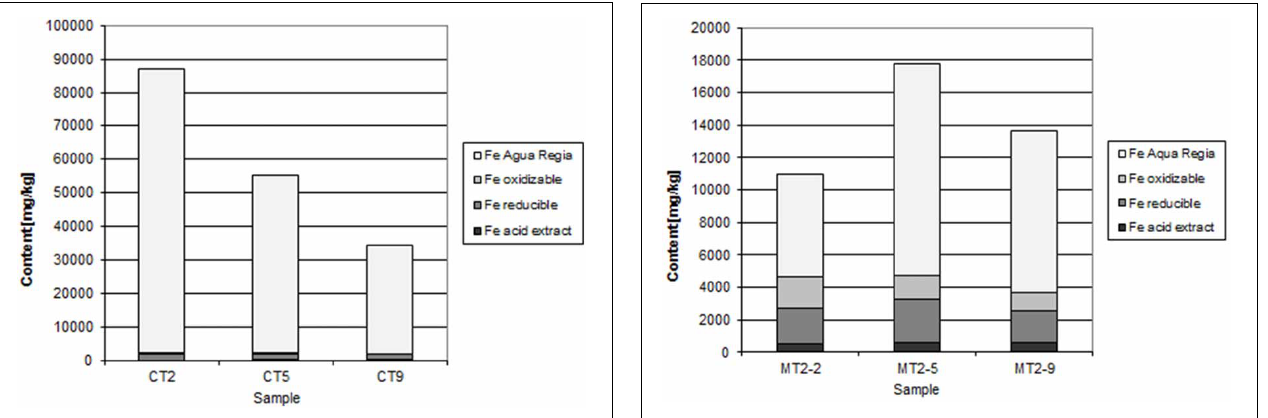
FIGURE 8 | Sequential extraction of Mindolo samples: Fe.